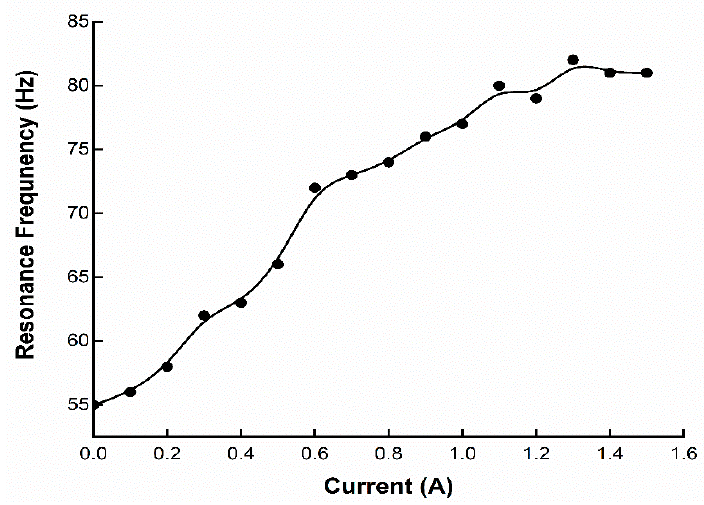
Figure 6. Resonance frequency response of ATVA under different magnetic fields.